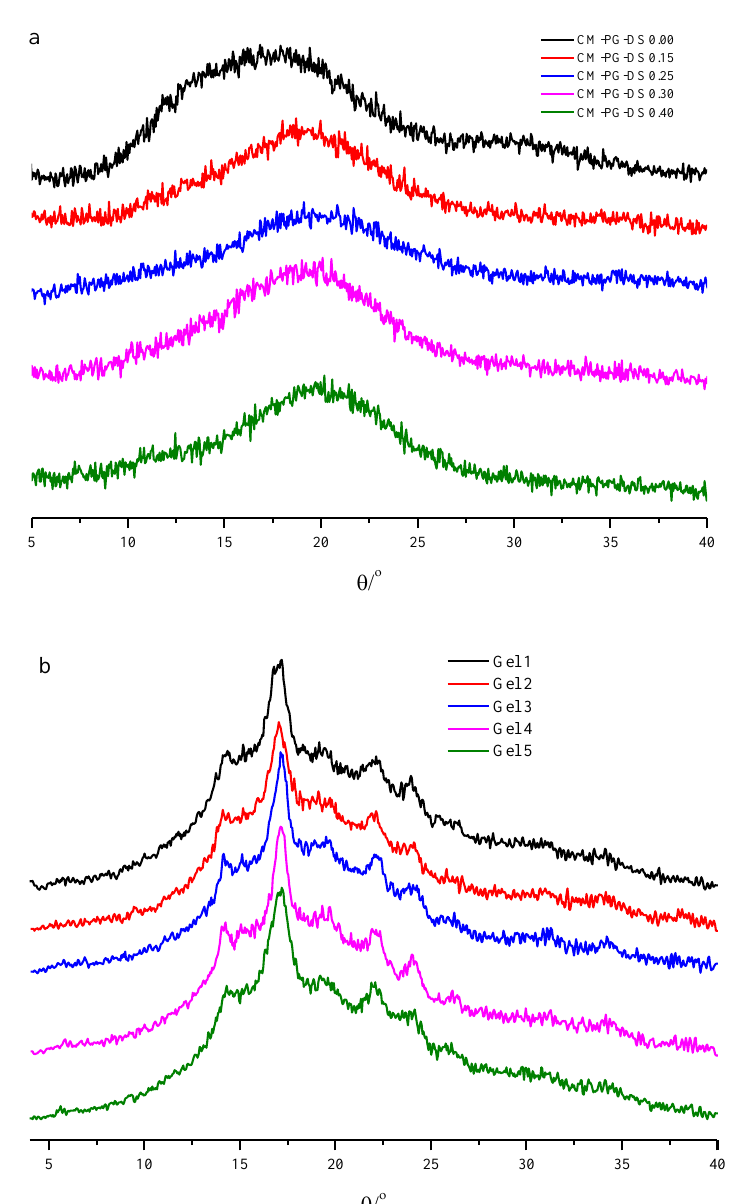
Figure 2. X-ray diffraction patterns of ( a ) CM-PG and ( b ) lyophilized hydrogels.